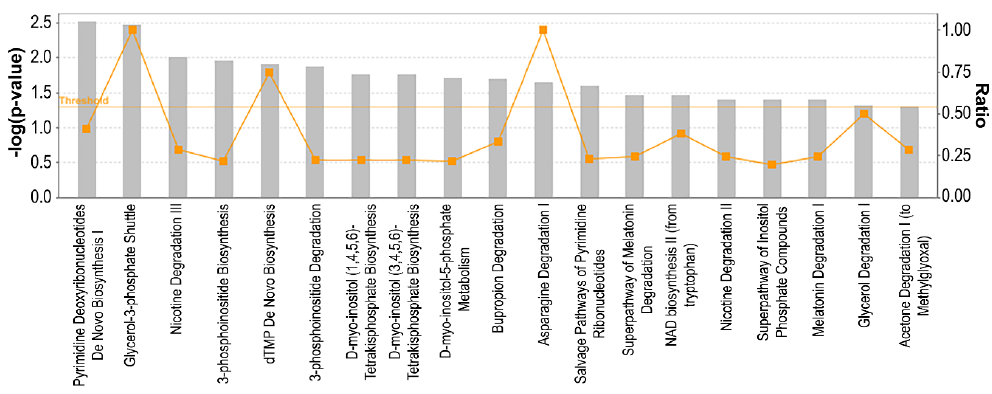
Figure 5. Metabolic pathway analysis of ER+ palbociclib-resistant breast cancer cells. A higher–log( p - value) shown on the left Y axis represents more significant pathways. The ratio (right Y axis) refers to the number of genes from the dataset that map to the pathway divided by the total number of genes that map the canonical pathway from the IPA database. pval ≤ 0.05; qval ≤ 0.05; |log 2 FC| ≥